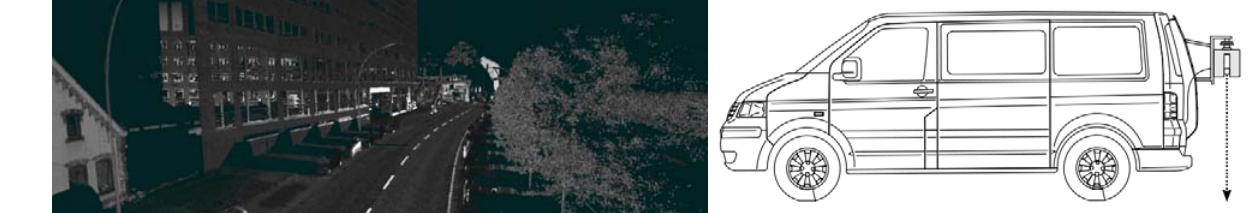
Figure 1. Left: Sample rendering of a point cloud created with the presented system, Right: Illustration of the scan device